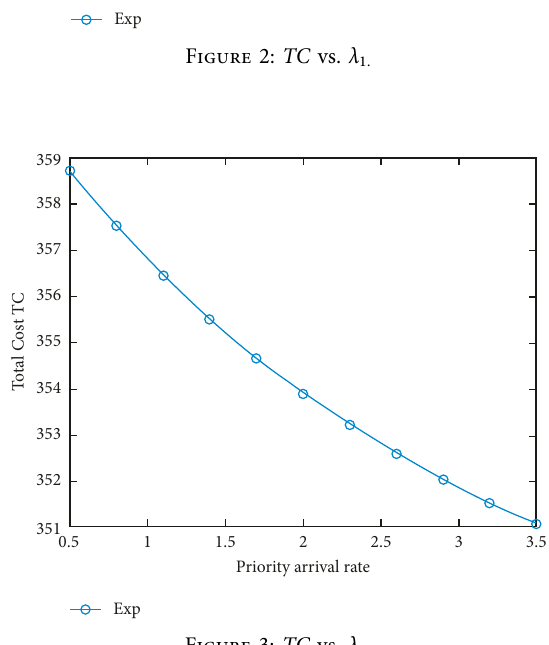
Figure 2: TC vs. λ